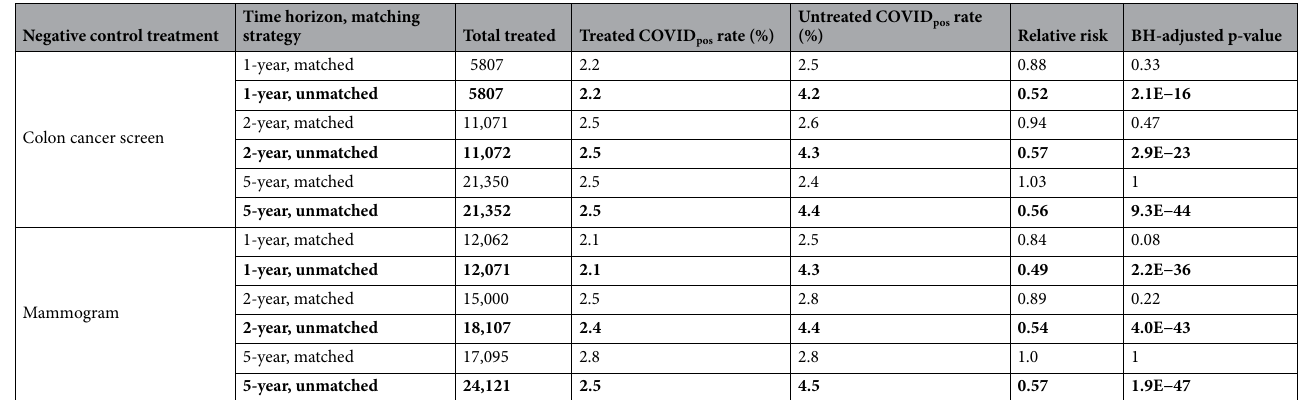
Table 12. Summary of SARS-CoV-2 rates for individuals who did vs. did not receive negative control treatments before and after propensity score matching. SARS-CoV-2 positive rates, relative risks, and associated BH-adjusted Fisher exact p-values for individuals who received or did not receive negative control treatments over the past 1 year, 2 years, and 5 years prior to PCR test. The negative control treatments considered are: (1) Colon cancer screen and (2) Mammogram. The BH adjustment is applied per time horizon, as in the main analysis. Numbers are shown before and after propensity score matching. Unmatched numbers are shown in